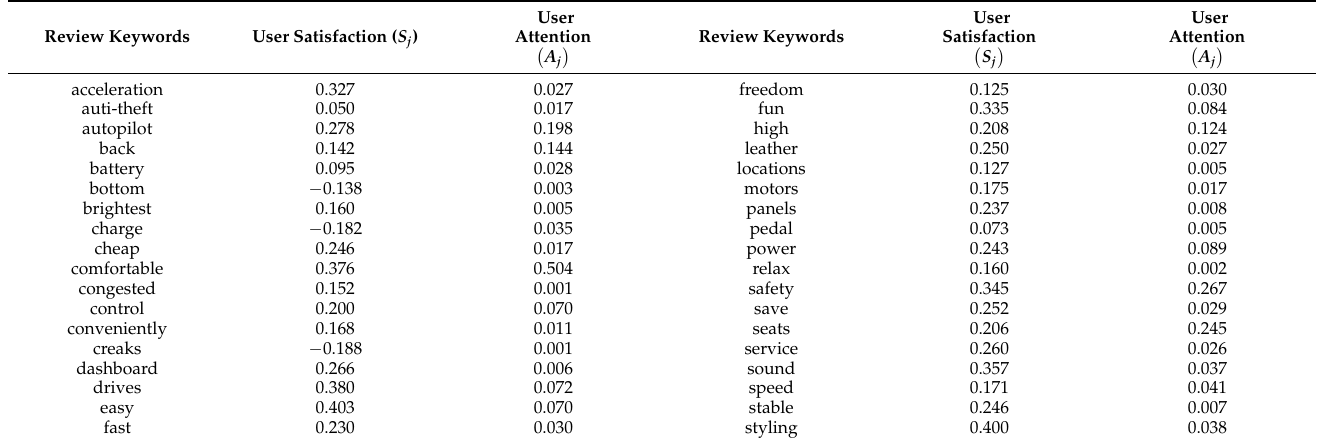
Table 5. User satisfaction and attention of review keywords in the EVs